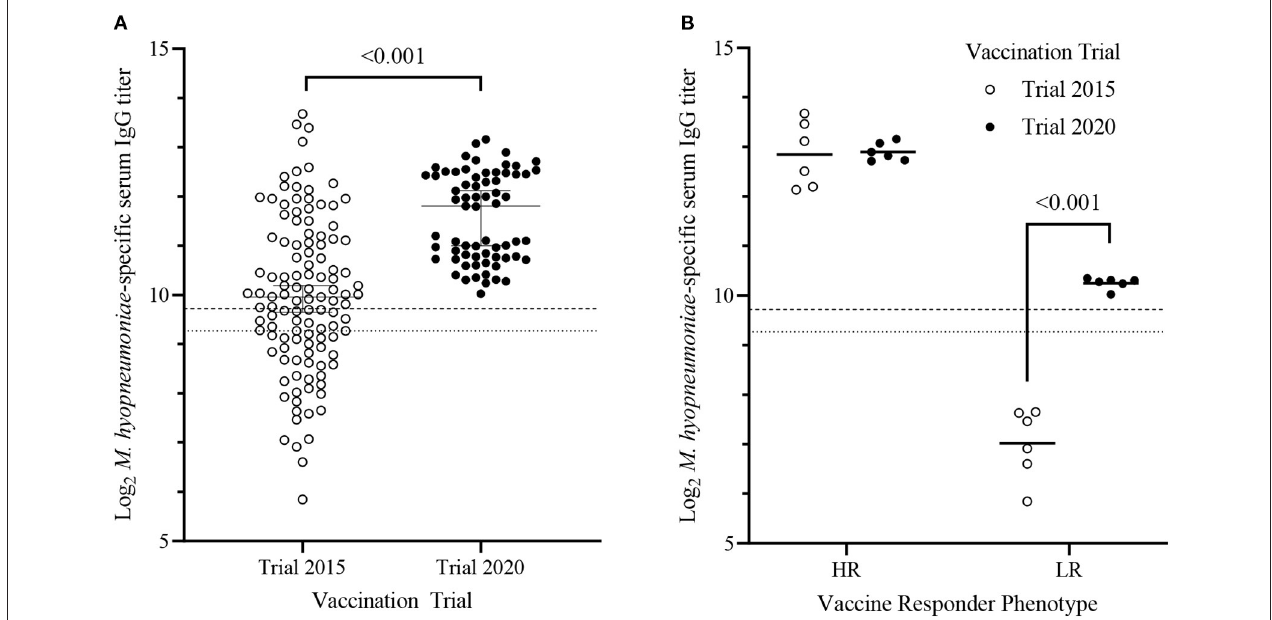
FIGURE 1 | Mycoplasma hyopneumoniae -specific serum IgG titers of piglets from Trial 2015 and Trial 2020 11-days following RespiSure-One booster vaccination. (A) Median ( ± 95% confidence interval) Log 2 M. hyopneumoniae –specific serum IgG titers of piglets from Trial 2015 ( n = 117; open circles) and Trial 2020 ( n = 67; solid circles). Differences were determined using a 2-sample Kolmogorov–Smirnov test. (B) Mean serum M. hyopneumoniae –specific IgG titers of the high (HR) and low (LR) responders within Trial 2015 ( n = 6/cohort; open circles) and Trial 2020 ( n = 6/cohort; closed circles). The horizontal bar represents the group mean. Dashed and dotted lines represent the threshold for seropositive and seronegative cutoffs, respectively. Differences were determined using a two-tailed, unpaired Student’s t -test with Welch’s